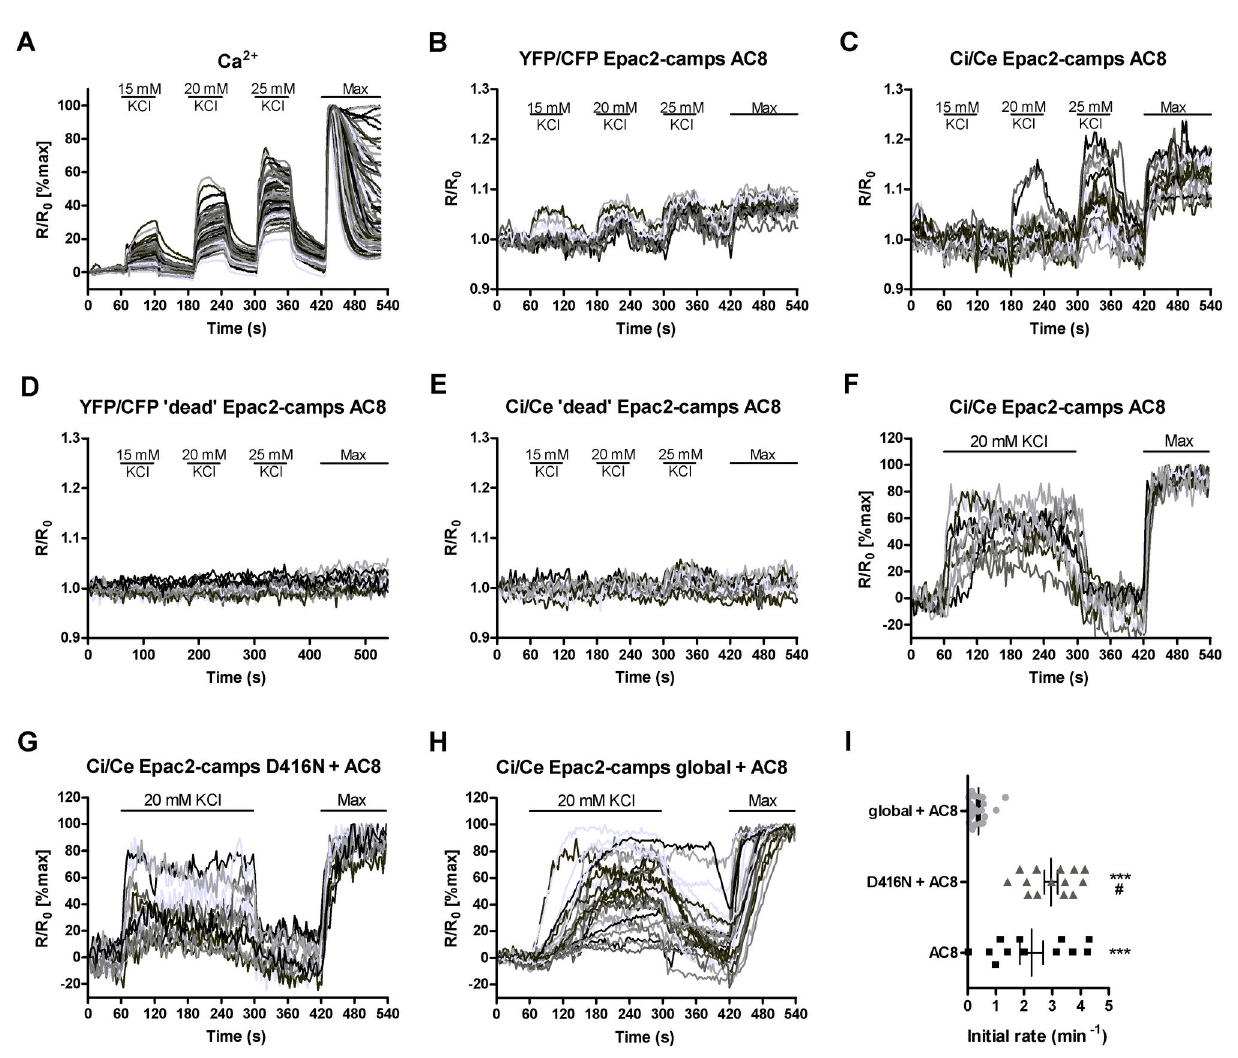
Figure 3. Characterisation of the AC8-targeted sensor in MIN6 cells. ( A ) Ca 2+ measurements in fura-2 loaded MIN6 cells depolarised with increasing concentrations of KCl in the presence of 1.3 mM Ca 2+ . Traces represent individual cells (n=96 cells from a representative experiment) ( B )-( E ) cAMP measurements in MIN6 cells expressing the indicated sensor and depolarised with increasing concentrations of KCl in the presence of 1.3 mM Ca 2+ . Traces represent individual cells (( B ) n=15 cells, ( C ) n=19 cells, ( D ) n=19 cells and ( E ) n=11 cells from 5-6 independent experiments). ( F ) -(H) cAMP measurements in MIN6 cells expressing the indicated constructs and depolarised with 20 mM KCl in the presence of 1.3 mM Ca 2+ . Traces represent individual cells (( F ) n=11 cells, ( G ) n=13 cells and ( H ) n=26 cells, from 5-7 independent experiments). ( I ) The initial rate of FRET change for each cell represented in panels ( F )-( H ) was calculated and shown a scatter plot with the mean and SEM. Data was normalised between the time point before depolarisation and the peak reached within the first two minutes following depolarisation. The initial rate of FRET change was calculated over the first 12 s (five data points) for each cell. Cells that did not respond to depolarisation were excluded from this analysis. *** p<0.0001 compared to global+AC8, # p>0.05 compared to AC8 measured by ANOVA with Tukey’s post